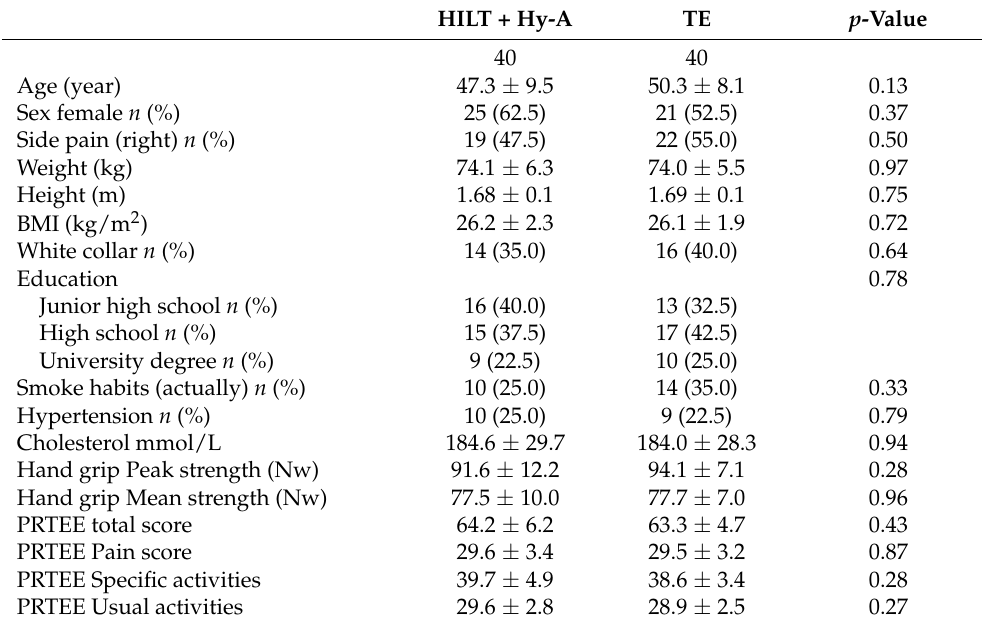
Table 1. Description of the population characteristics according to type of treatment at enrollment. High-intensity laser therapy plus hyaluronic acid (Hilt + Hy-A), therapeutic exercise (TE); Patient- Rated Tennis Elbow Evaluation (PRTEE).